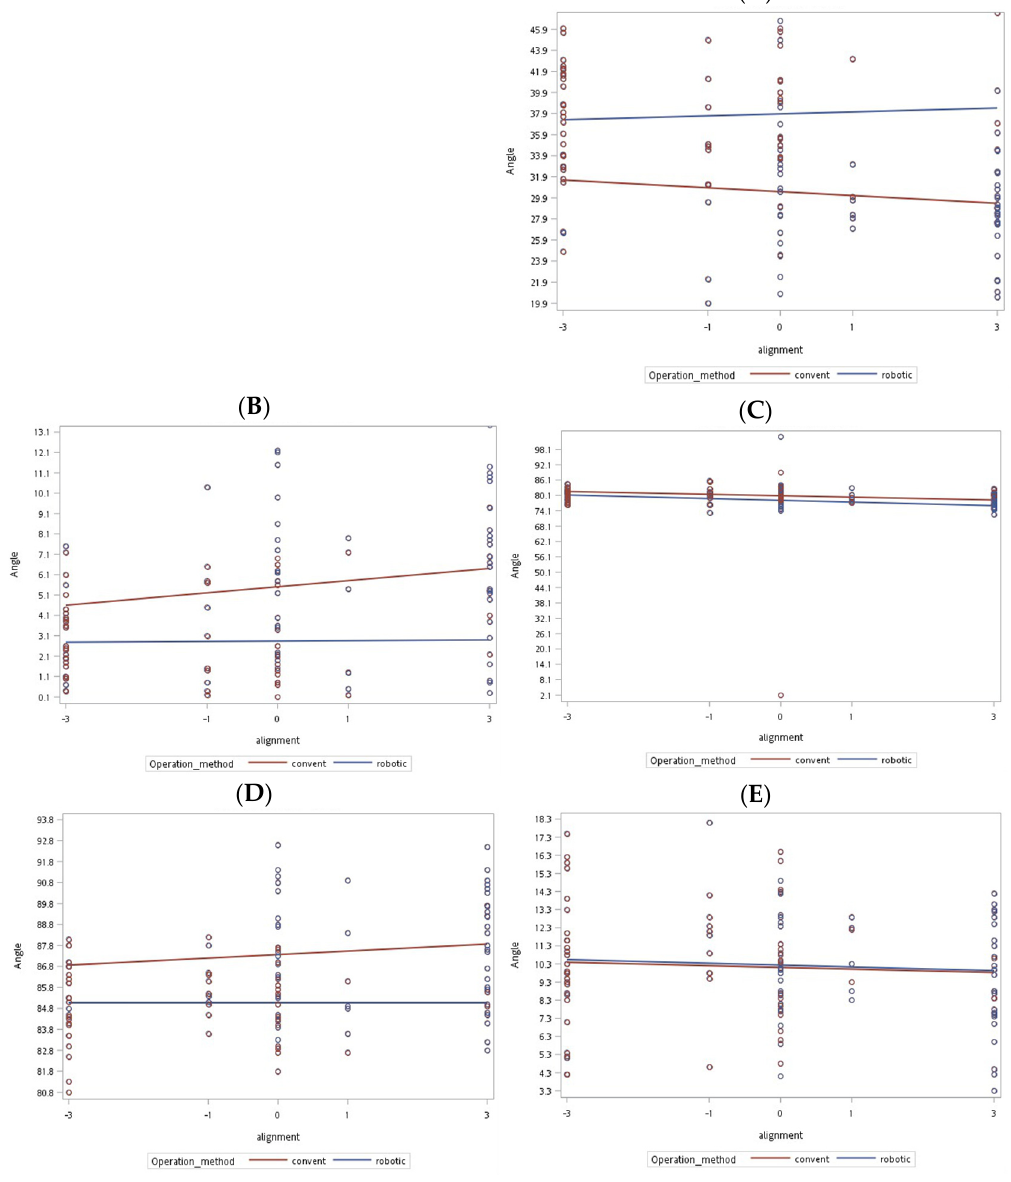
Figure 3. Distribution of the parameter measurements of postoperative bone alignment angles and implant positioning in both groups. ( A ) Femoral implant angle. ( B ) Postoperative anatomical axis angle. ( C ) Postoperative anatomical axis angle. ( D ) Postoperative femoral condyle angle. ( E ) Postoperative tibial slope angle. Abbreviations: convent = conventional.